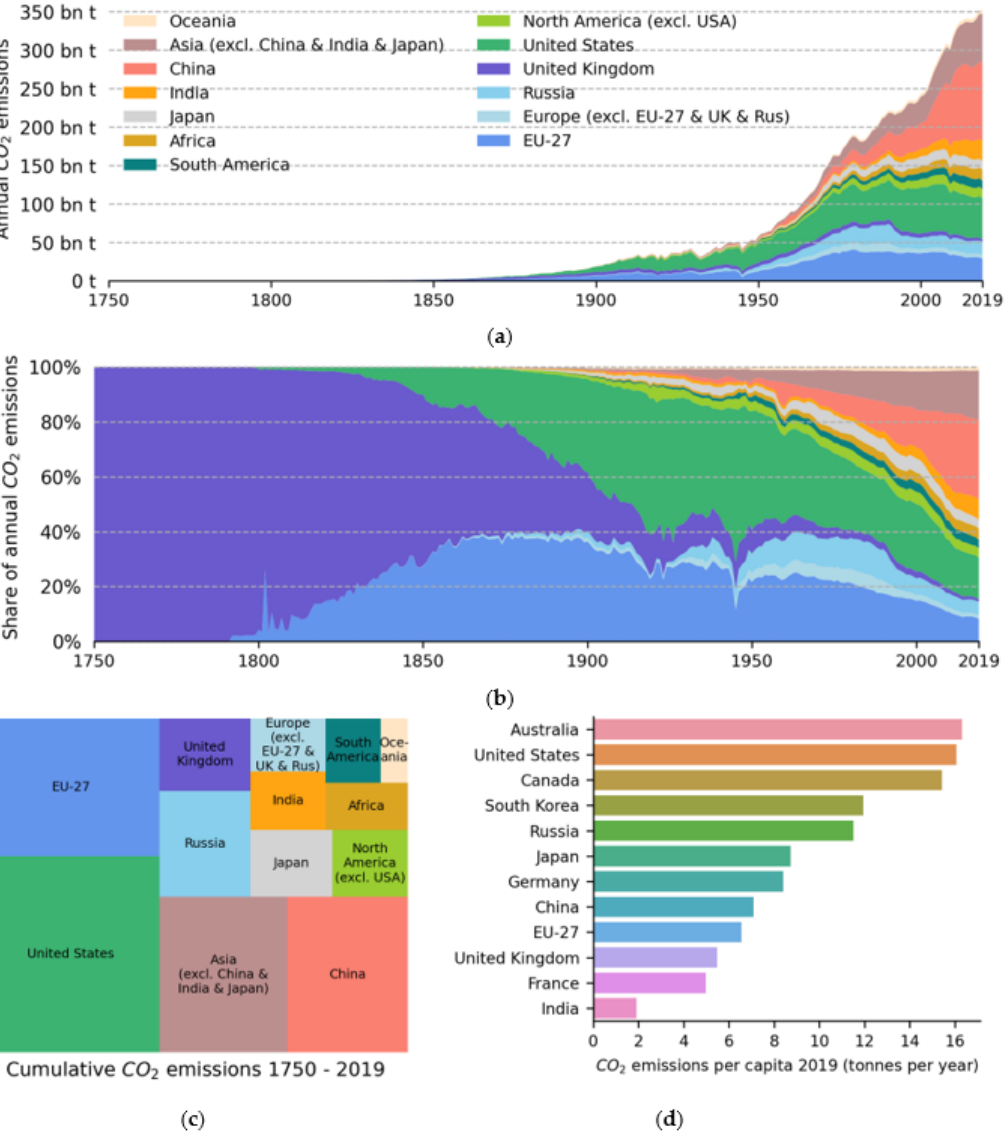
Figure 1. ( a ) World’s annual CO 2 emissions share by countries and regions; ( b ) world’s annual CO 2 emissions share by countries and regions; ( c ) world’s accumulated CO 2 emissions by countries and regions from 1750–2019; ( d ) per capita CO 2 emissions for selected countries/regions in 2019 (data compiled from [9]).